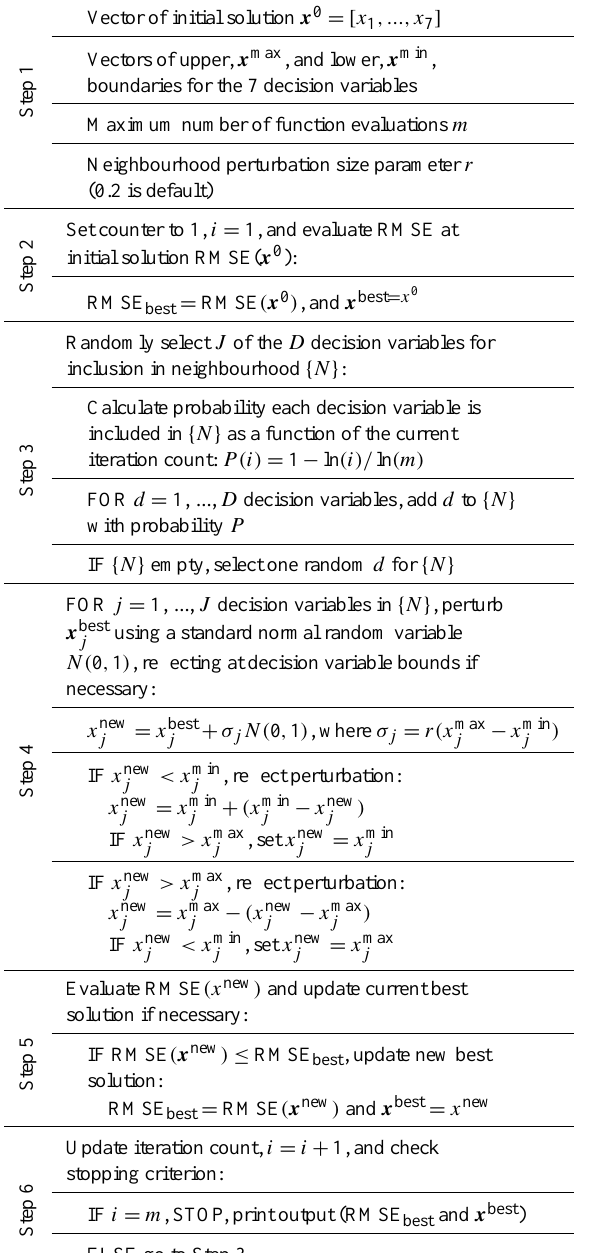
Fig. 8. (a) The automatic snow classification in PRACTISE cre- ates a DN frequency histogram of the blue band values (blue-green bars) of the superimposed DEM pixel positions (Fig. 6). The distri- bution is smoothed with a moving average window size of 5 (black line) and the snow threshold (green line) is selected for the first lo- cal minimum beyond a DN ≥ 127 (red line). (b) In the overlay, all DEM pixels with a DN in the blue band in the range from the snow threshold to 255 are classified as snow (red dots), while all other pixels are assigned as no snow (blue